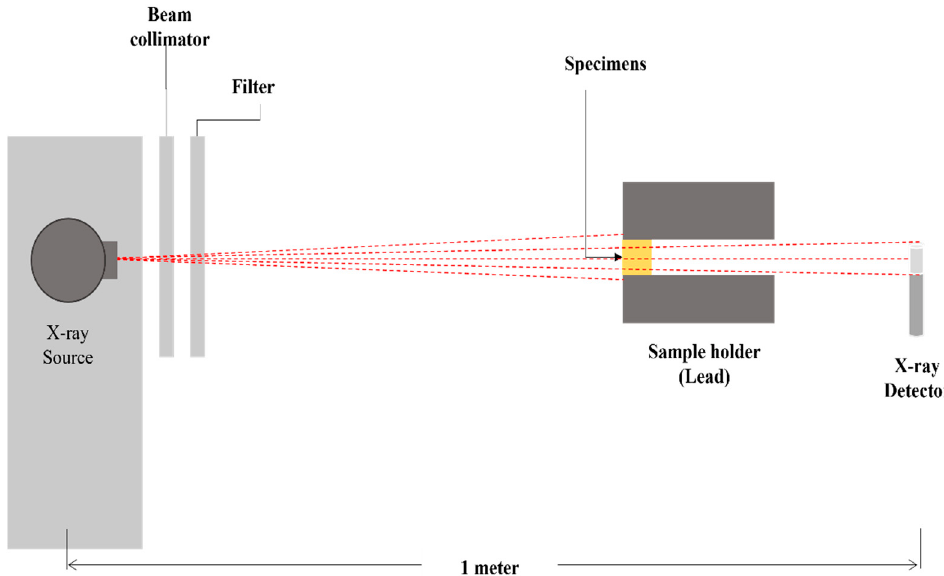
Figure 5. The experimental setup used for shielding efficiency proposed composite materials.